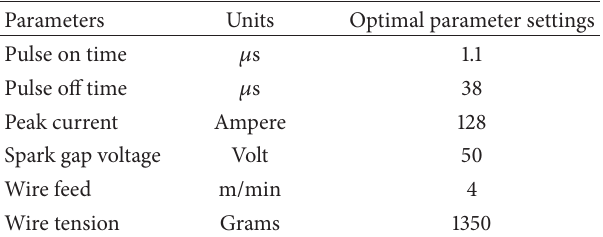
Table 9: Multioptimal parametric settings for MRR, overcut, and surface